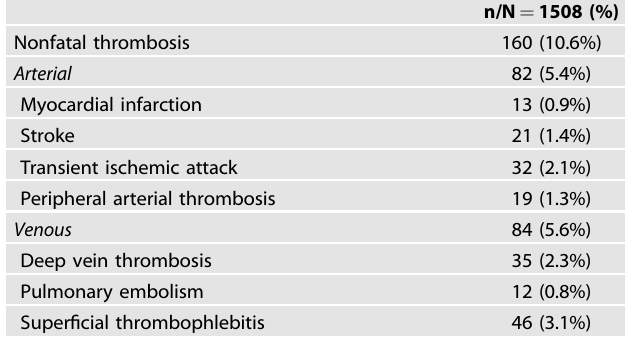
Table 1. Types of 160 nonfatal thrombosis during follow-up (median follow-up time: 2.51